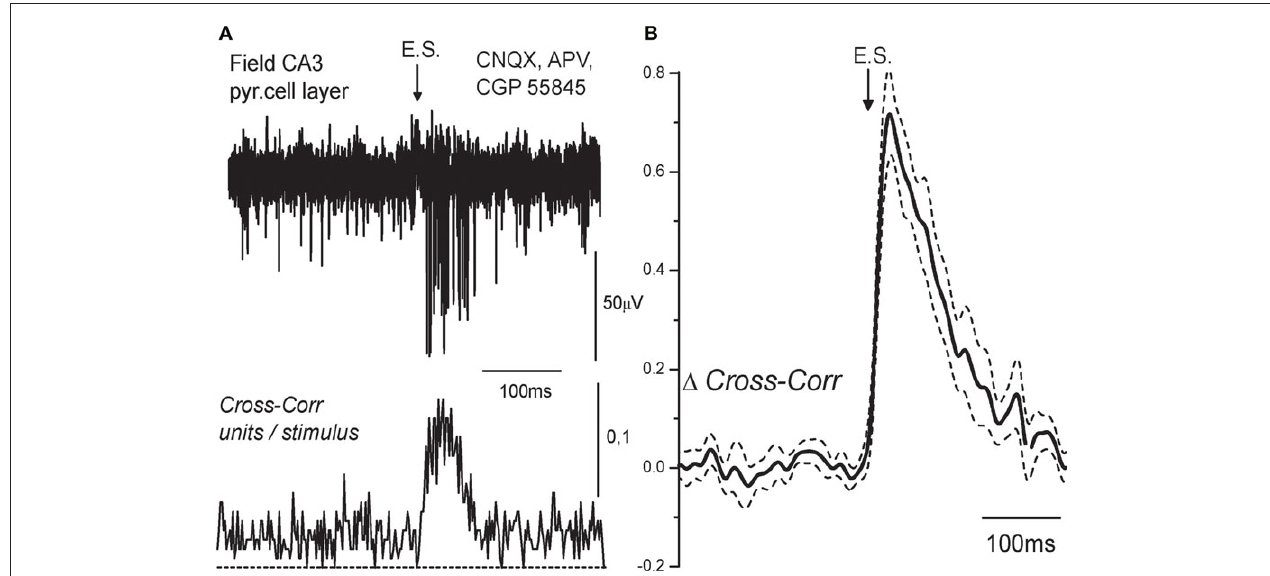
Figure 1 | Temporal characteristics of excitation at gABAergic synapses using extracellular recordings. (A) Extracellular recordings of the action potentials (APs) evoked by electrical stimulation (ES) in the presence of the AMPA, NMDA, and GABA(B) receptor antagonists (10 μM CNQX, 40 μM D-APV,